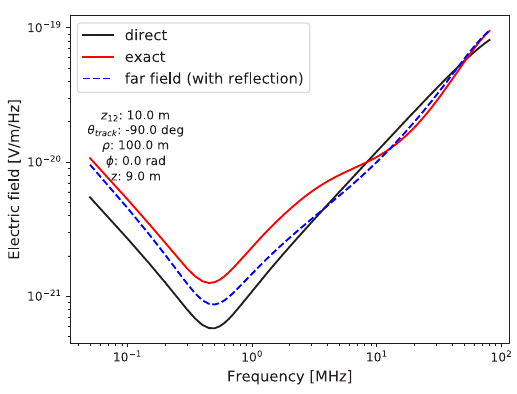
Figure 3. Top: Direct, direct plus reflected (far field) and exact fields for a vertical particle track lying 10 m above the ground. The observer is located at 9 m of height at a radial distance of 100 m from the track.